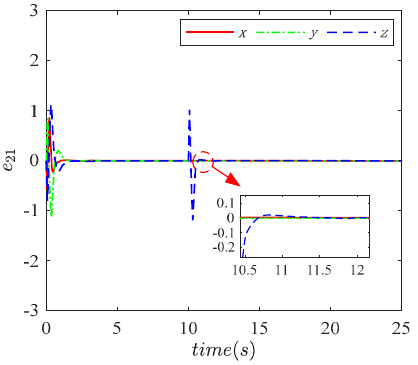
Figure 10. Disturbance estimation errors of MAV.